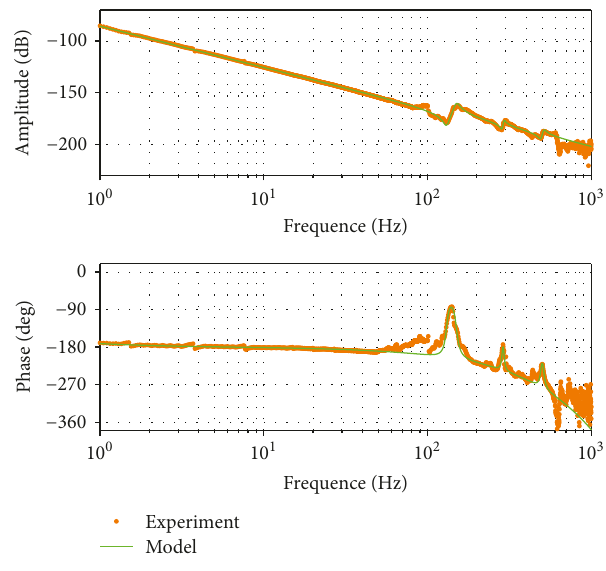
Figure 3: Frequency response functions in Bode representation of the x -direction long-stroke wafer stage.